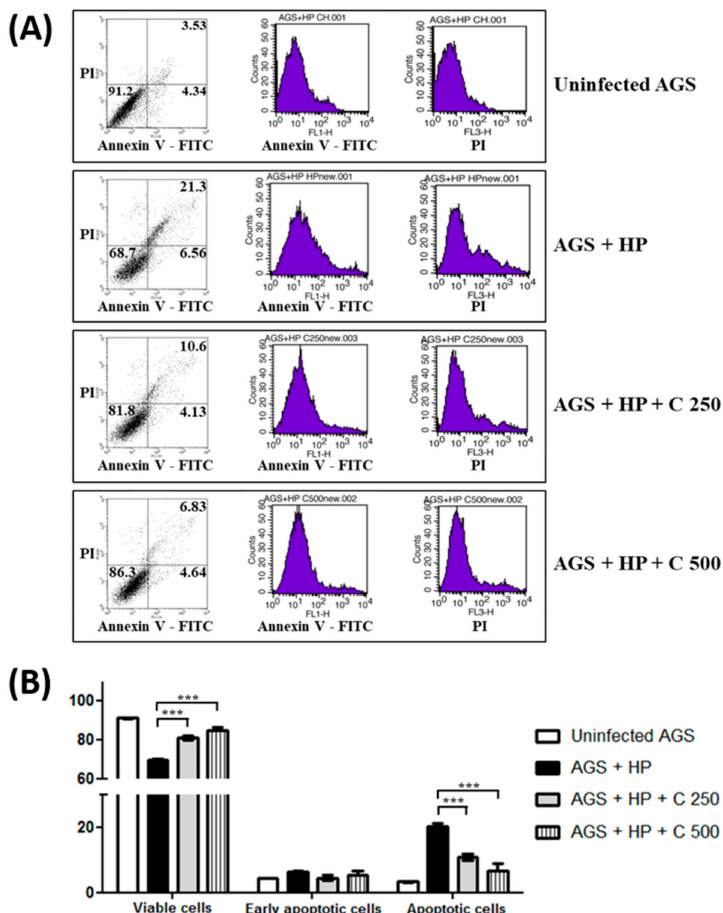
Figure 3. E ff ect of β -caryophyllene on apoptosis of AGS cell infected with H. pylori . AGS cells were infected with H. pylori (200 MOI) and treated with indicated dose of β -caryophyllene (250 and 500 µ g / mL) for 24 h. After incubation, the cells were stained with annexin V-FITC and PI and subjected to flow cytometry. β -caryophyllene alleviated apoptosis of AGS cells induced by H. pylori infection. ( A ) Stained cells were analyzed and illustrated on the quadrant by CellQuestPro software. ( B ) The percentage of cells in apoptosis was analyzed and illustrated as a graph. Results from triplicate experiments were analyzed by Student’s t -test (*** p <